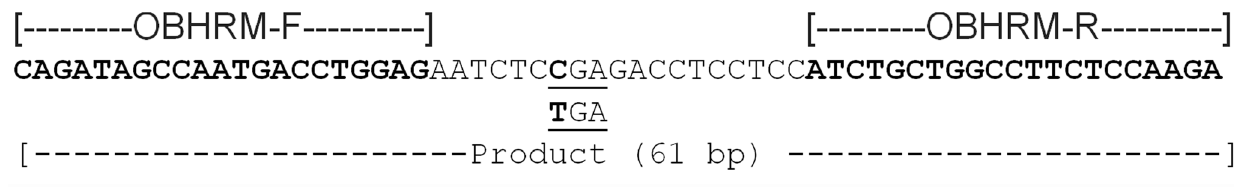
Figure 1. Primers and product around Lep ob SNP that yields premature stop codon.